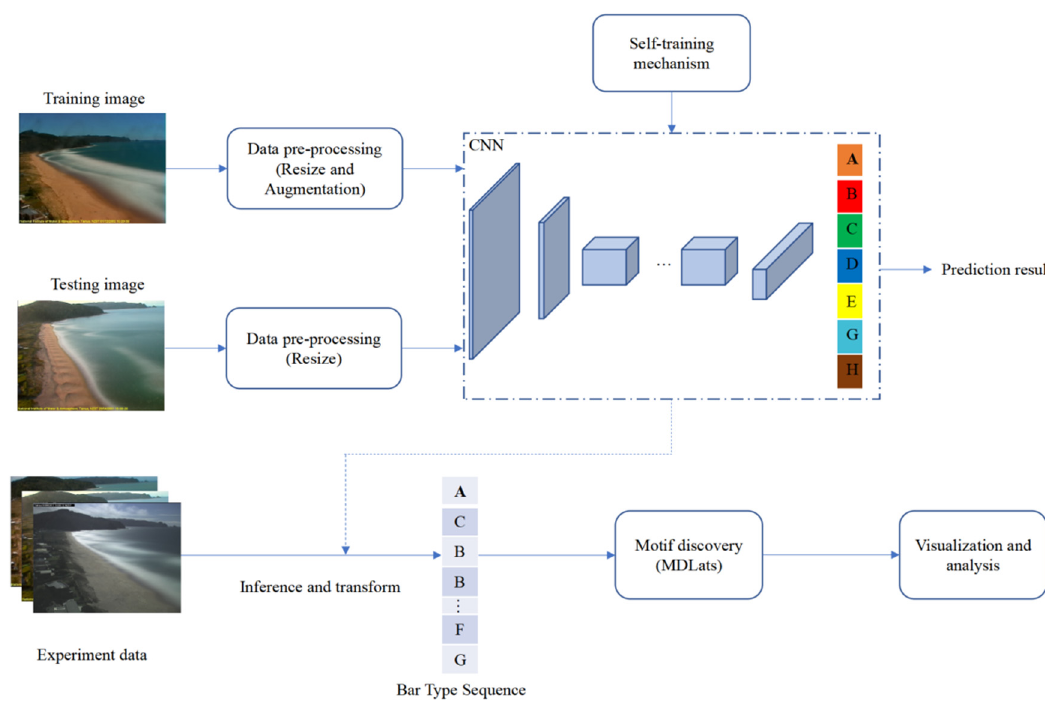
Figure 3. Overview of the proposed method.